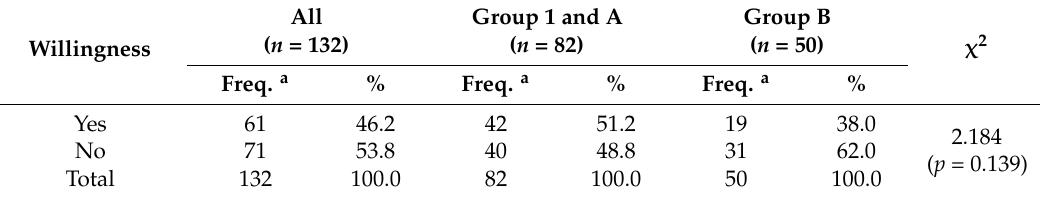
Table 7. Difference of willingness to invest in FCO projects between the respondents with forest management contracts (FMCs) (Group 1+A) and those with no management contracts (Group B).